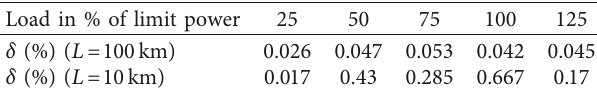
Figure 2: Oscillograms of the electrical units in case of 2-phase fault: (1) current and its derivative received on the model and (2) analytical current and its derivative functions received based on